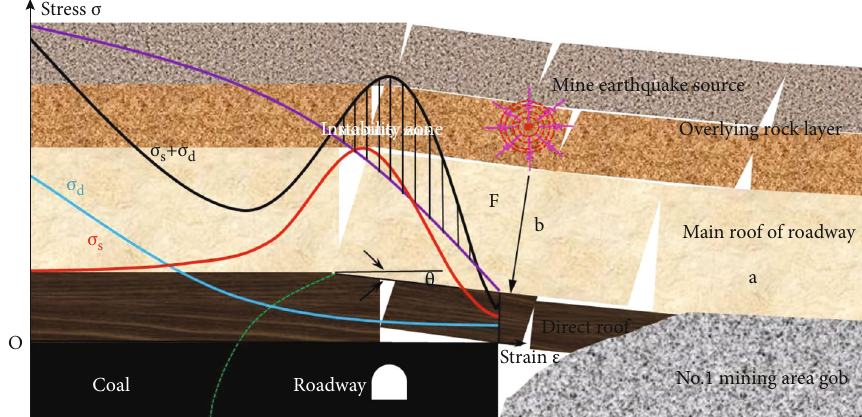
Figure 9: Structure of the side roof in the goaf of main roadway.